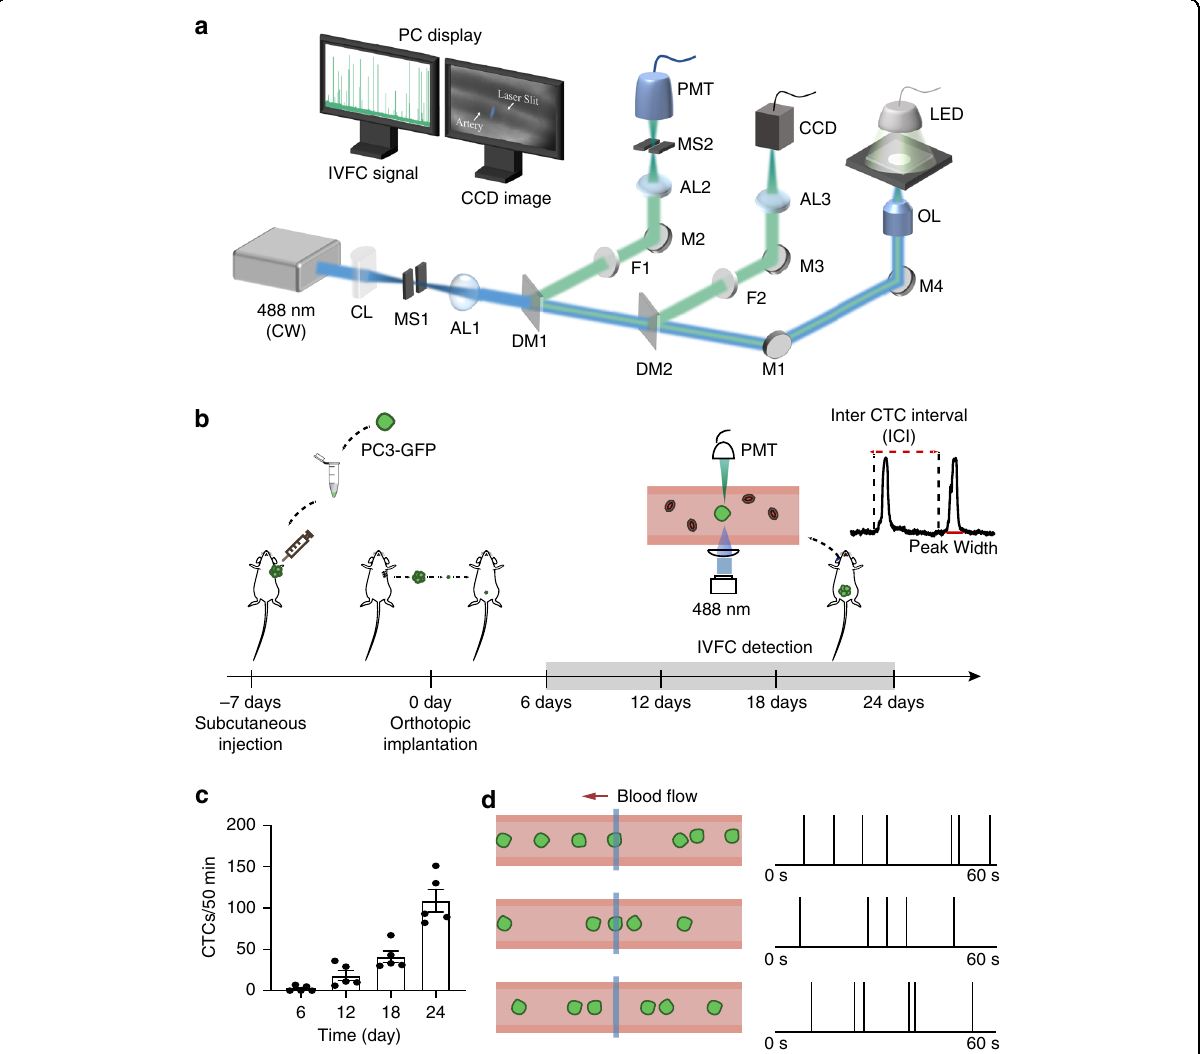
Fig. 1 Monitoring prostate cancer CTCs by fl uorescence IVFC. a Schematic of the fl uorescence IVFC experimental setup. CL: cylindrical lens;